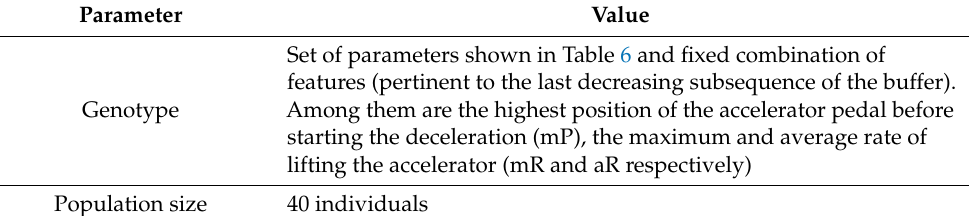
Table 8. Main parameters of the GA for the evolution of values of hyperparameters of the classifier.